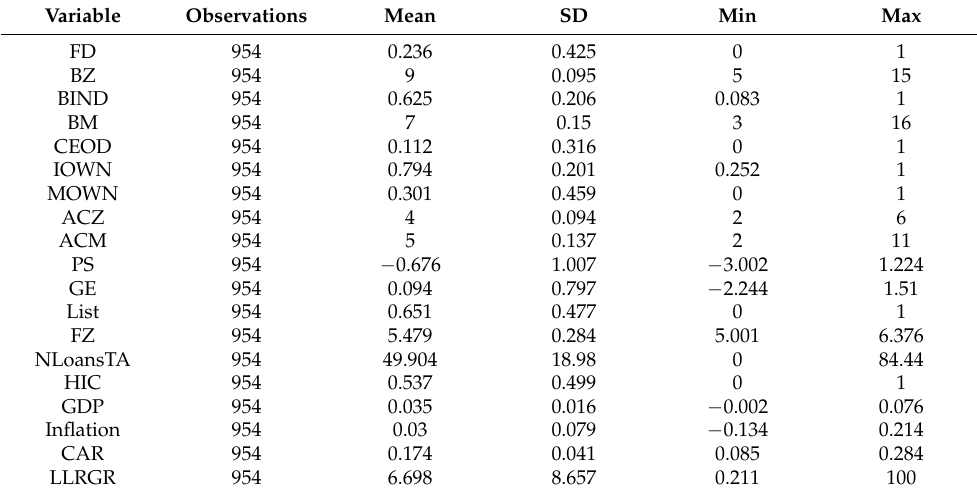
Table 3. Descriptive statistics for variables in the main